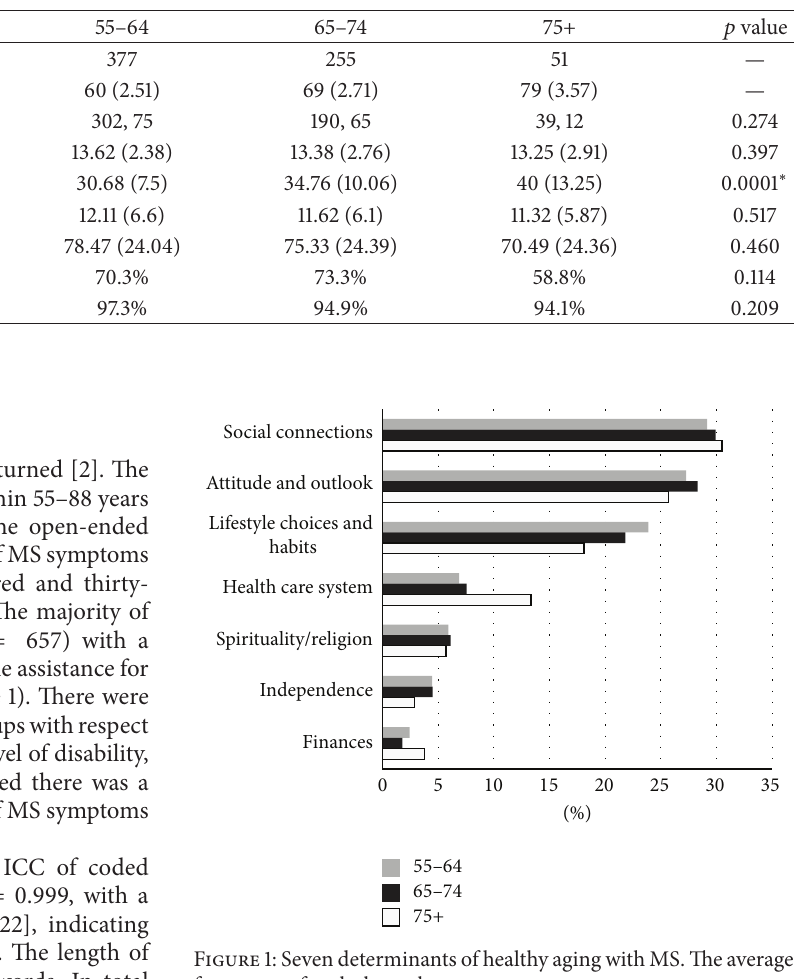
Table 1: Participant characteristics by age group.